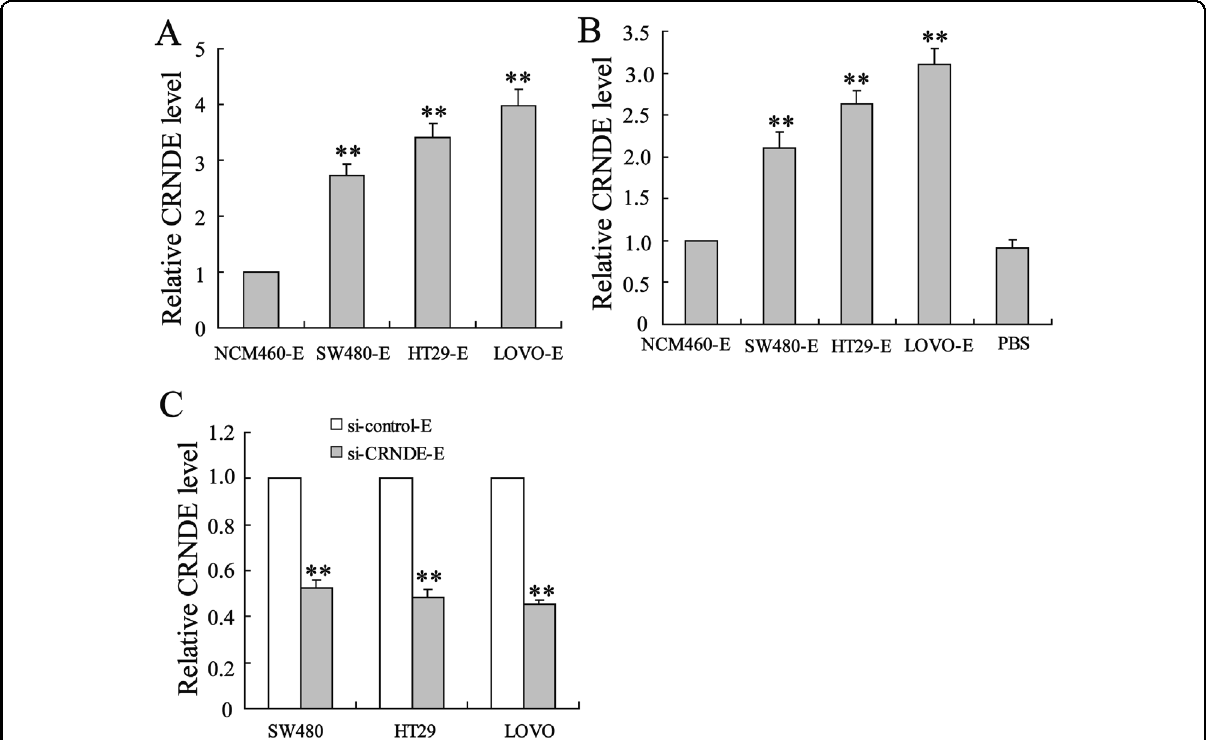
Fig. 2 The effects of CRC cell exosome on the expression of CRNDE-h in CD4 + T cells. A The expressions of CRNDE-h in SW480-exosome (SW480-E), HT29-exosome (HT29-E), LOVO-exosome (LOVO-E), and normal colon epithelial cell-exosome (NCM460-E) were detected by qRT-PCR. B The SW480-E, HT29-E, LOVO-E, and NCM460-E (20 μ g/mL) were co-cultured with naive CD4 + T cells isolated from the PMBCs of healthy subjects for 24 h. Then, the expression of CRNDE-h in T cells was detected by qRT-PCR. The “ μ g/mL ” in this study means the protein concentration of exosomes. C CRC cells (SW480, HT29, and LOVO) were transfected with si-CRNDE-h (or si-control), and then used to isolate exosomes. Exosomes were co-cultured with naive CD4 + T cells isolated from the PMBCs of healthy subjects. Then, the expression of CRNDE-h in T cells was detected by qRT- PCR. E: exosome. ** p < 0.01 vs. NCM460-E or